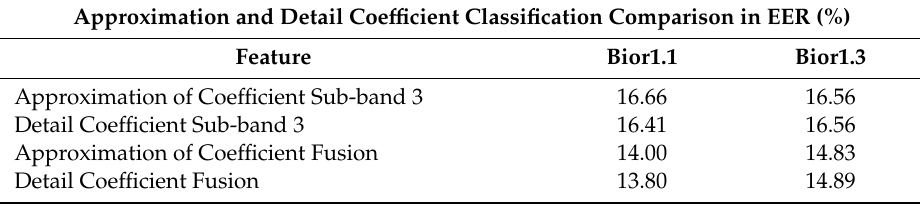
Table 3. Showing the approximation of coe ffi cient and detail coe ffi cient classification.